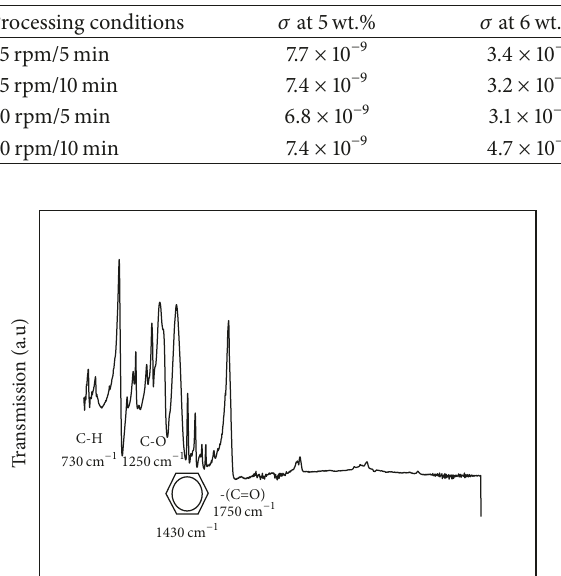
Table 1: Electrical conductivity of PET with GNP loading of 5wt.% and 6wt.% measured at different processing condition.